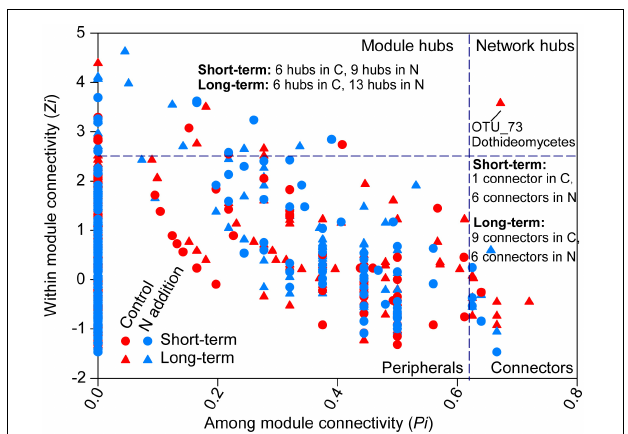
FIGURE 7 | Classification of nodes to identify putative keystone species within the networks. The topological role of each OTU is determined according to the scatter plot of within-module connectivity ( Zi ) and among-module connectivity ( Pi ). Module hubs have Zi > 2.5, whereas connectors have Pi > 0.62. The number of module hubs and connectors is presented on the plot and the network hub is labeled with the OTU number. The abbreviations of C and N are defined as control and N addition, respectively. Detailed taxonomic information for module hubs and connectors is shown in Supplementary Tables 4–7